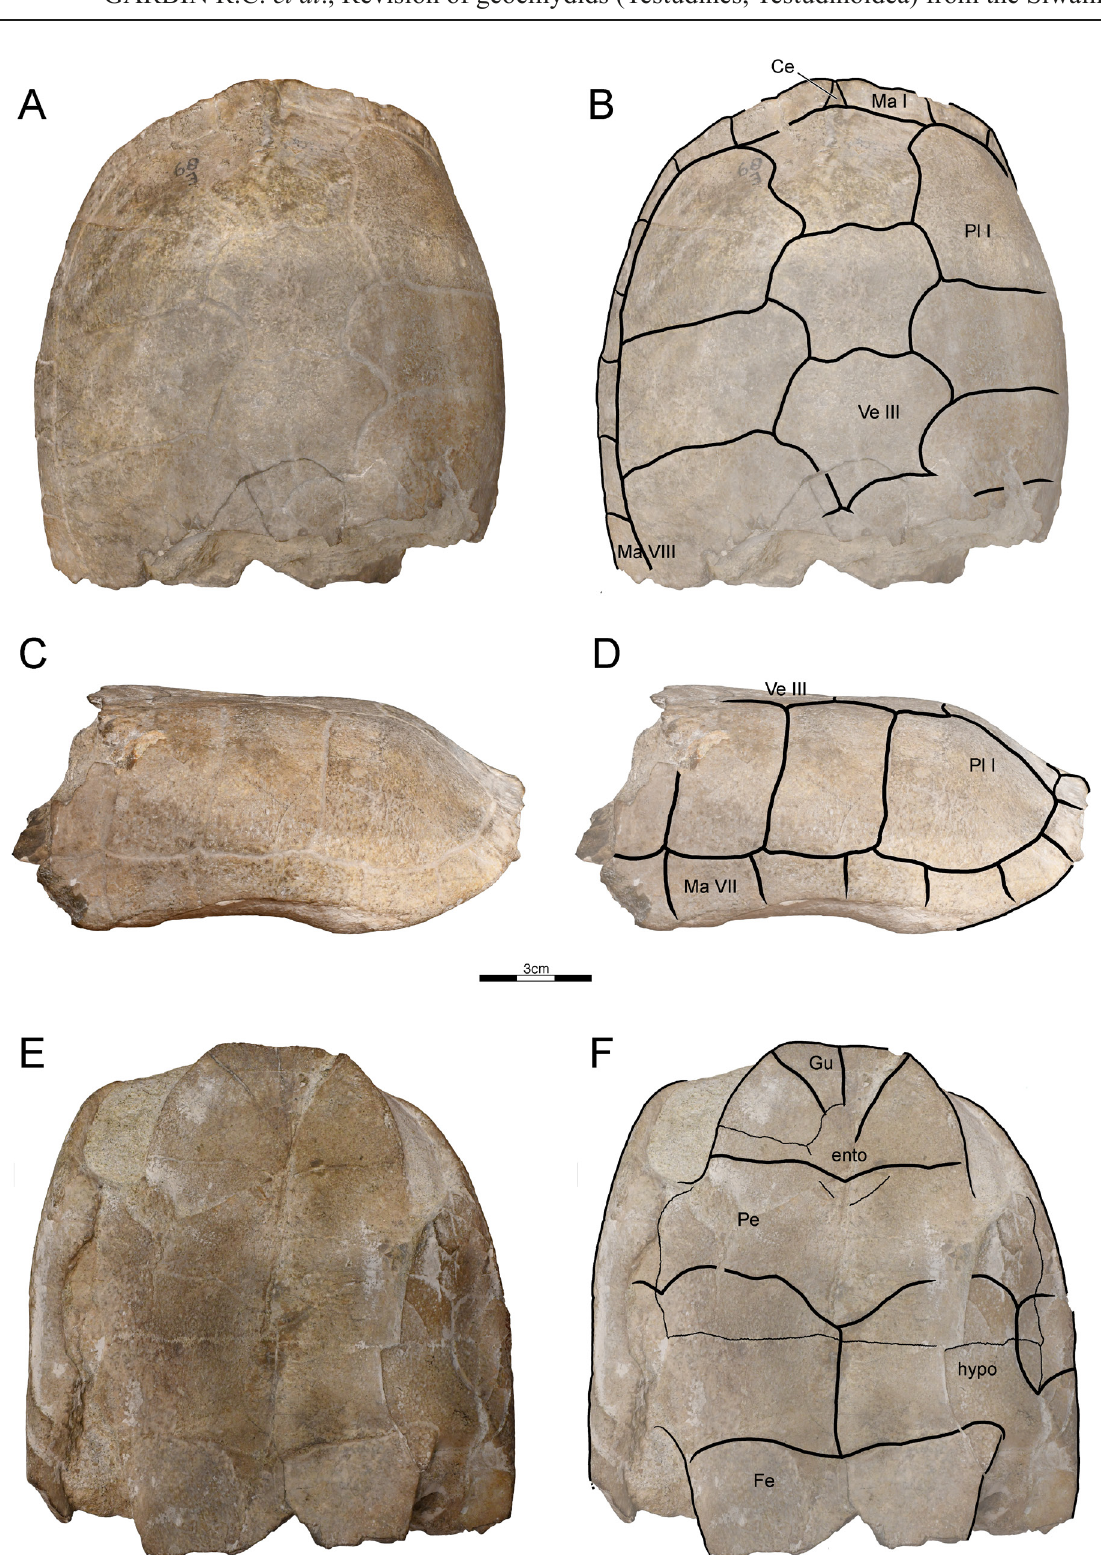
Fig. 28. IM E.89, holotype of Clemmys theobaldi Lydekker, 1885, here identified as Melanochelys sivalensis (Theobald, 1877) comb. nov. A . Photograph of carapace. B . Illustration of carapace. C . Photograph of carapace in lateral view. D . Illustration of carapace in lateral view. E . Photograph of plastron. F . Illustration of plastron. Scale bar: